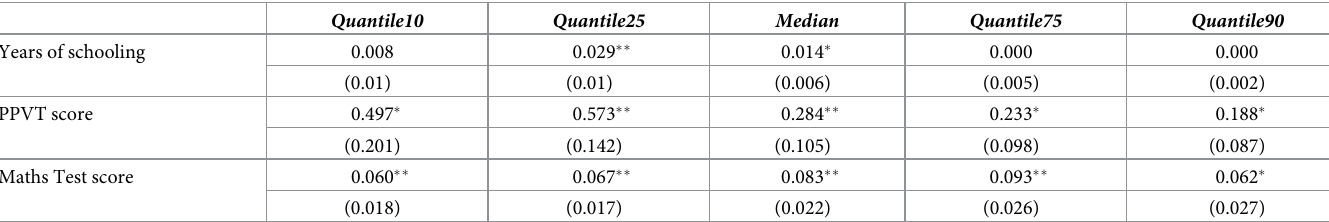
Table 5. Quantile regression coefficients of CLG on educational outcomes @